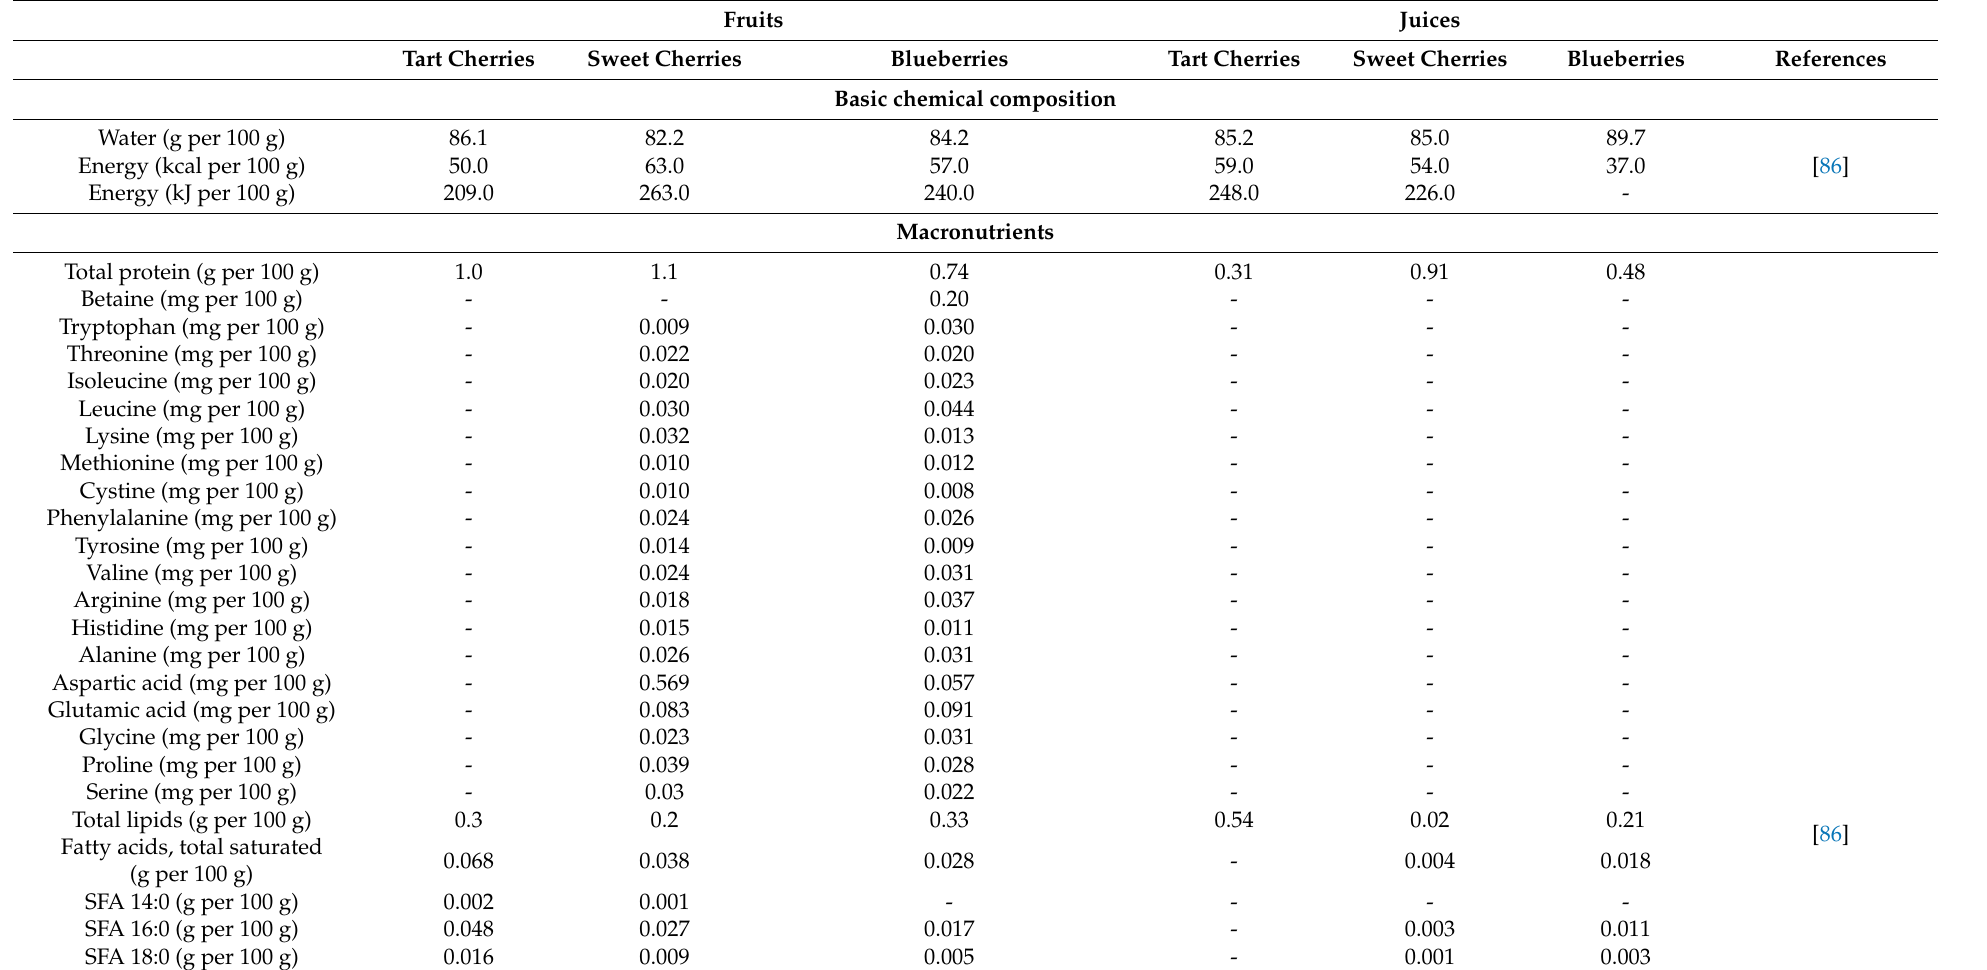
Table 6. Nutritional composition and main phenolic compounds found in tart and sweet cherries, and highbush and rabbiteye blueberries (mg per 100 g of fresh weight (fw)) and juices (mg/L). Fruits